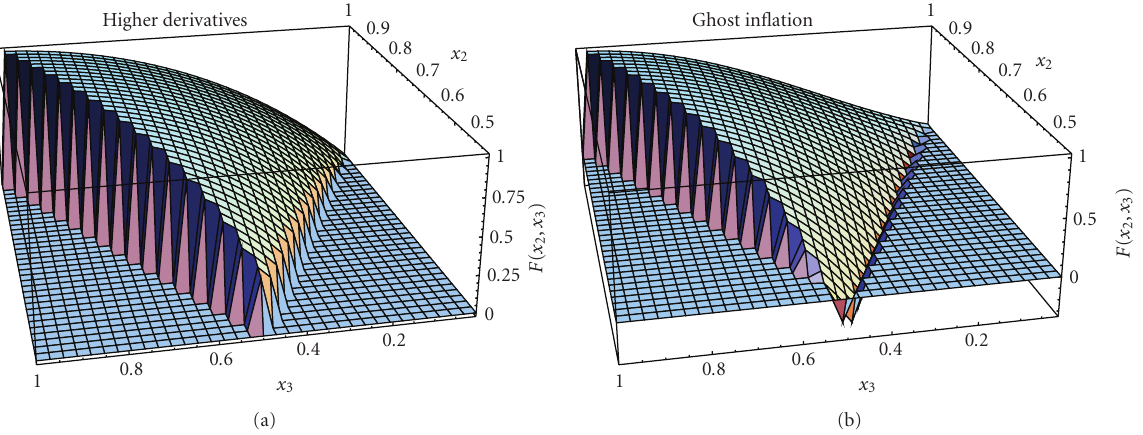
Figure 5: Plot of the function F (1, x 2 , x 3 ) x 2 2 x 2 3 for the inflation with higher derivatives as given by (22) (a) and the ghost inflation as given by (23) (b). The figures are normalized to have value 1 for equilateral configurations x 2 = x 3 = 1 and set to zero outside the region 1 − x 2 ≤ x 3 ≤ x 2 . Here x 3 ≡ k 3 /k 1 and x 2 ≡ k 2 /k 1 . The figures are taken from Babich et al. 2003